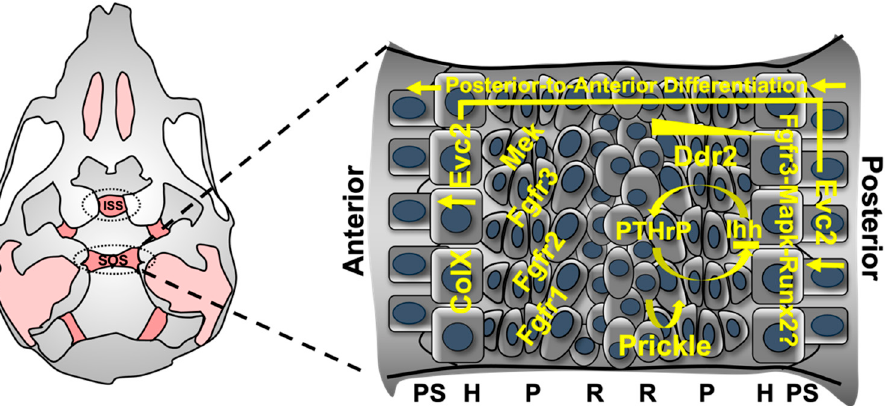
Figure 2. Molecular regulation of the postnatal cranial base synchondrosis. PTHrP-Ihh feedback regulates activity of proliferating chondrocytes until their differentiation into pre-hypertrophic cells. Prickle, a component of the Wnt/PCP pathway, directs asymmetric division of resting cells into adjacent columnar chondrocytes. Fgfr1 , Fgfr2 and Fgfr3 expression in proliferating chondrocytes directly controls cranial base elongation. Activating mutations in each receptor are associated with various forms of syndromic craniosynostoses, which commonly present midfacial hypoplasia. Evc2 expression is localized in a gradient-like fashion, wherein which levels increase in the anterior most portions of the SOS and ISS are indirectly regulated through Hedgehog signaling. This relationship instructs posterior-to-anterior differentiation and eventual mineralization of cranial base chondrocytes in addition to formation of the segmented cranial base bones. Ddr2 expression is found in a gradient fashion, with highest levels localized to resting cells. Currently established in the long bone growth plate, Fgfr3-Mapk-Runx2 signaling is a critical component regulating both chondrocyte proliferation and hypertrophy. Whether this relationship exists in the cranial base synchondrosis remains to be elucidated. ISS: inter-sphenoid synchondrosis, SOS: spheno-occipital synchondrosis, R: resting zone, P: proliferating zone, H: hypertrophic zone, PS: primary spongiosa.